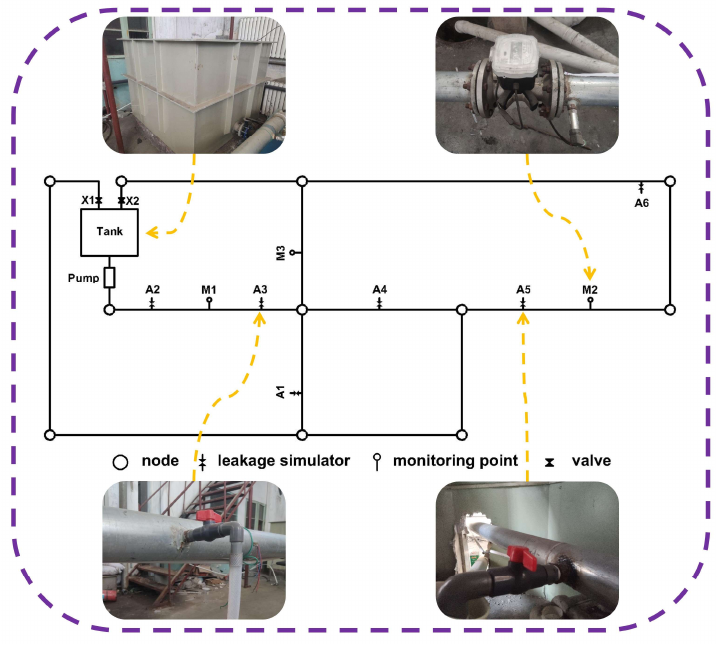
Figure 2. Experimental network system.